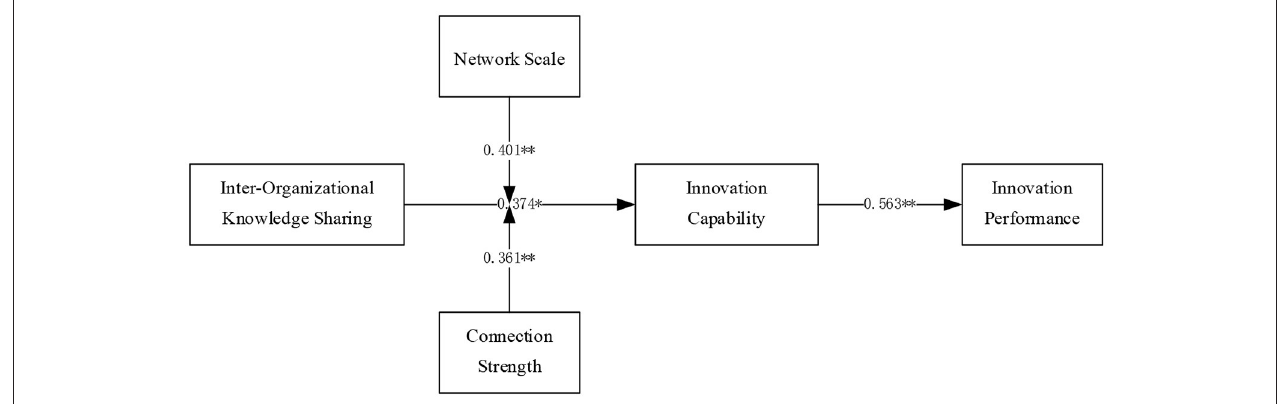
FIGURE 4 | Theoretical model with results. * p < 0.05; ** p < 0.01; *** p <